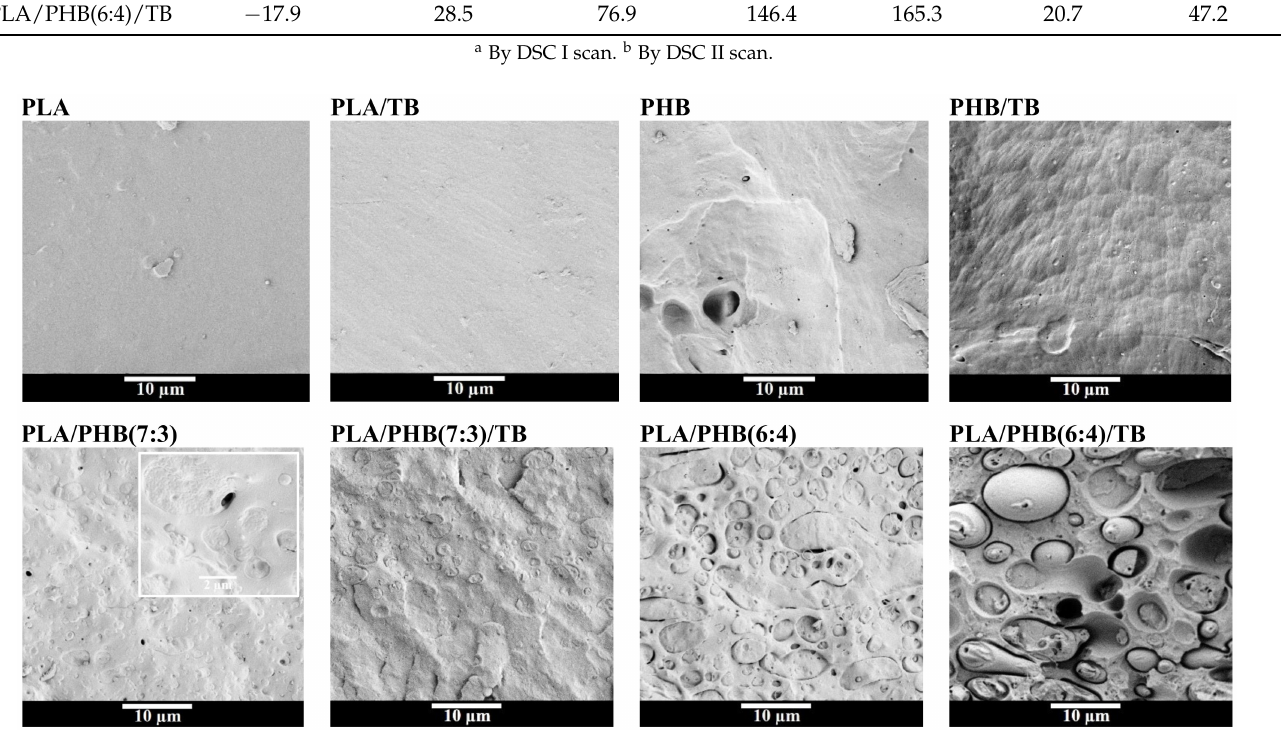
Figure 1. Morphological investigation of PLA and PHB based films fracture